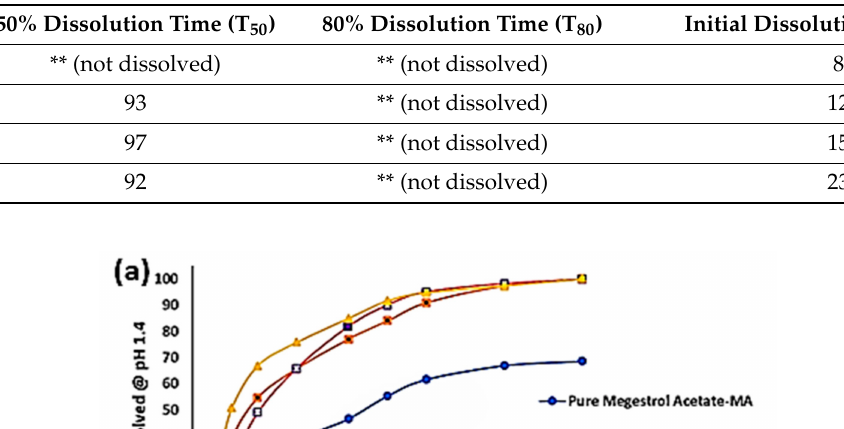
Table 3. Dissolution data at intestine pH (6.5) conditions.